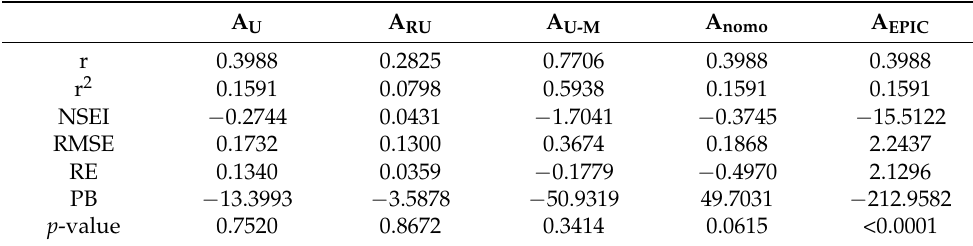
Table 5. Soil loss calculations by different soil loss estimation models (A U —USLE; A RU —RUSLE; A U-M —USLE-M; A nomo —USLE nomograph; A EPIC —EPIC nomograph) and their Pearson correlation coefficient (r), coefficient of determination (r 2 ), Nash–Sutcliffe coefficient (NSEI), root-mean-square error (RMSE), relative error (RE), percent bias (PBIAS), relative difference (R diff ) and p -value (Mann– Whitney U test), used to test models’ performance. A U A RU A U-M A